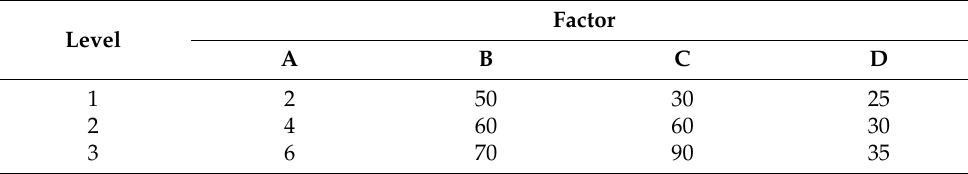
Table 1. Factors and levels in the design of the orthogonal